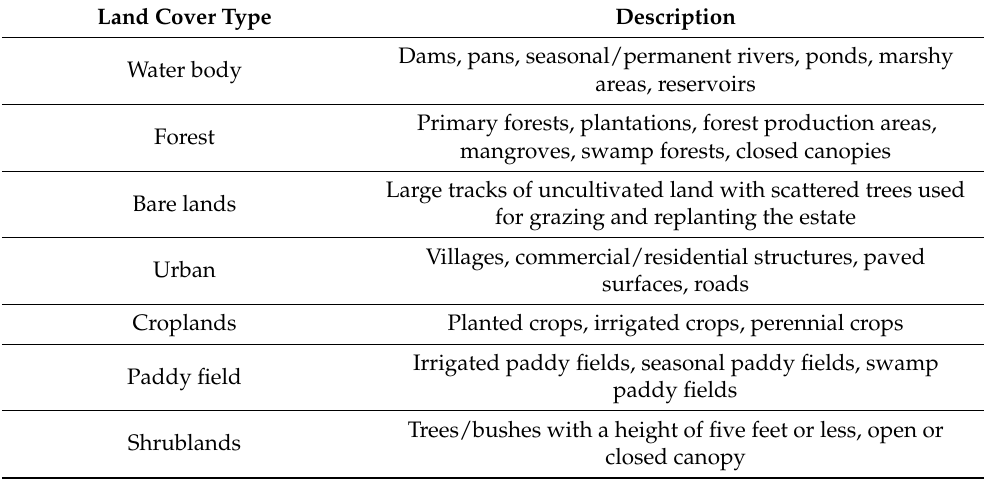
Table 1. Description of land use types in the study